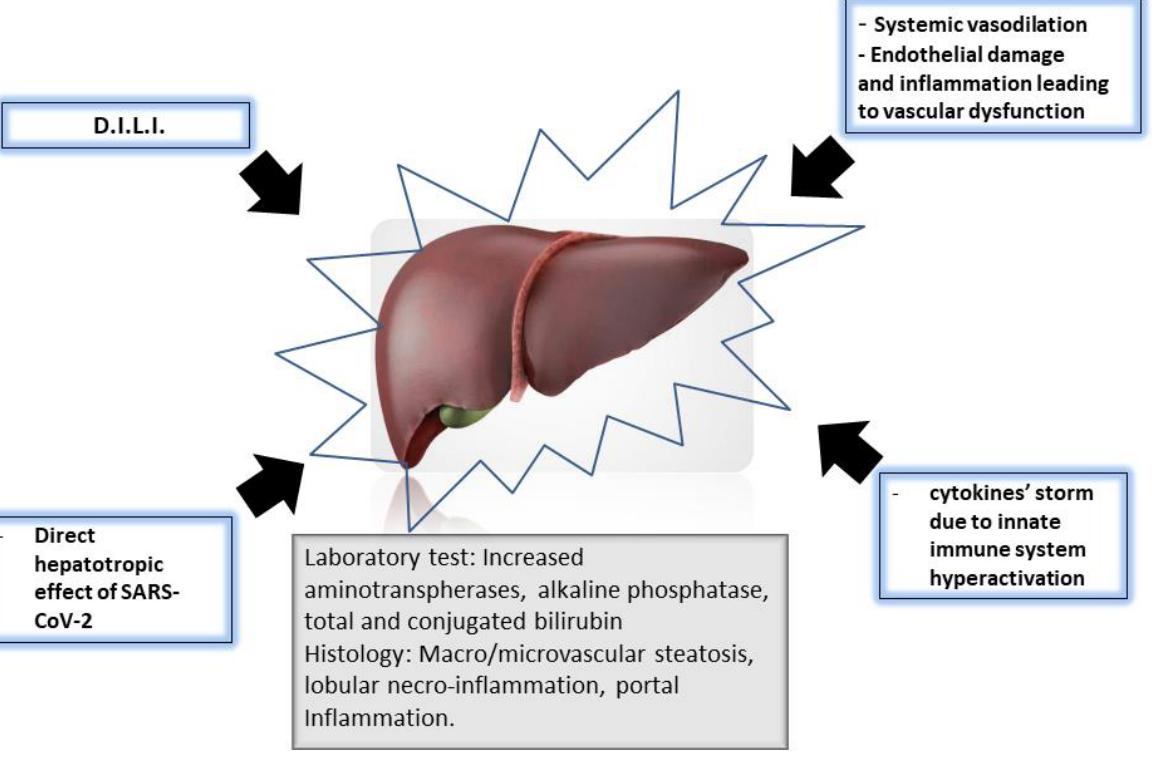
Figure 2. Pathophysiological mechanisms of coronavirus disease 2019 (COVID-19) liver injury. Legend: DILI, drug-induced liver injury; SARS-CoV-2, severe acute respiratory syndrome coronavirus. A special section is due to drug-induced liver damage (DILI) during COVID-19 treatment.